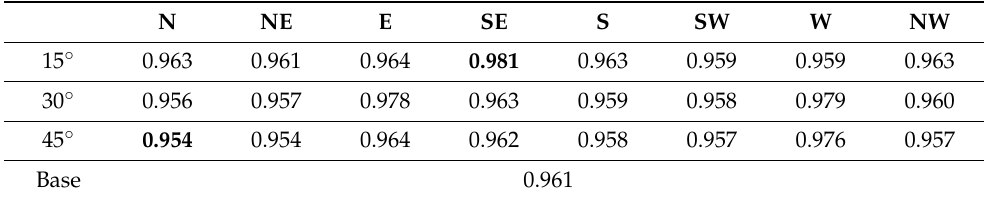
Figure 13. Ammonia uniformity index (UI) according to the various injection angle and direction candidates at the inlet of the SCR. Table 4. Ammonia uniformity index (UI) data according to the various injection angle and direc- tion candidates at the inlet of the SCR.